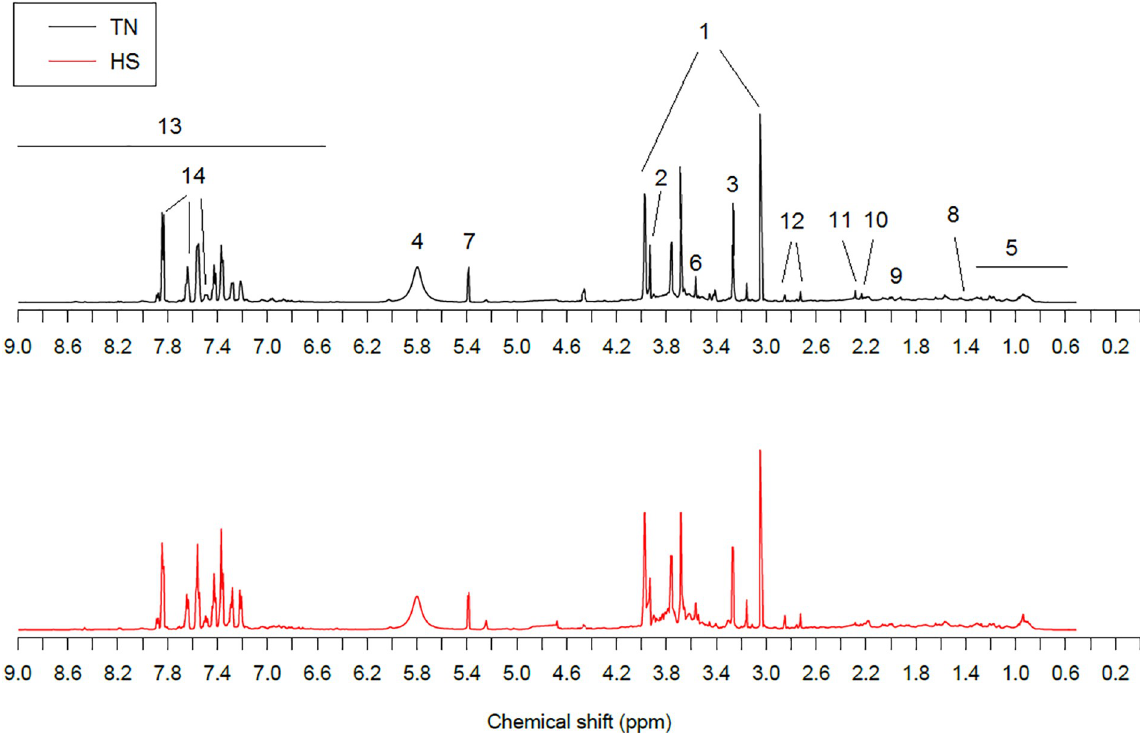
Fig 1. One-dimensional 1 H NMR spectra at 600 MHz of urine from representative thermoneutral (TN) and heat-stressed (HS) dairy does. Dominant metabolites were: 1, creatinine; 2, creatine; 3, trimethyl-N-oxide; 4, urea; 5, branched-chain amino acids and organic acids; 6, glycine; 7, allantoin; 8, alanine; 9, N-acetyl glycoprotein; 10, glutamate; 11, succinic acid; 12, citric acid; 13, aromatic signals; 14, hippuric acid.